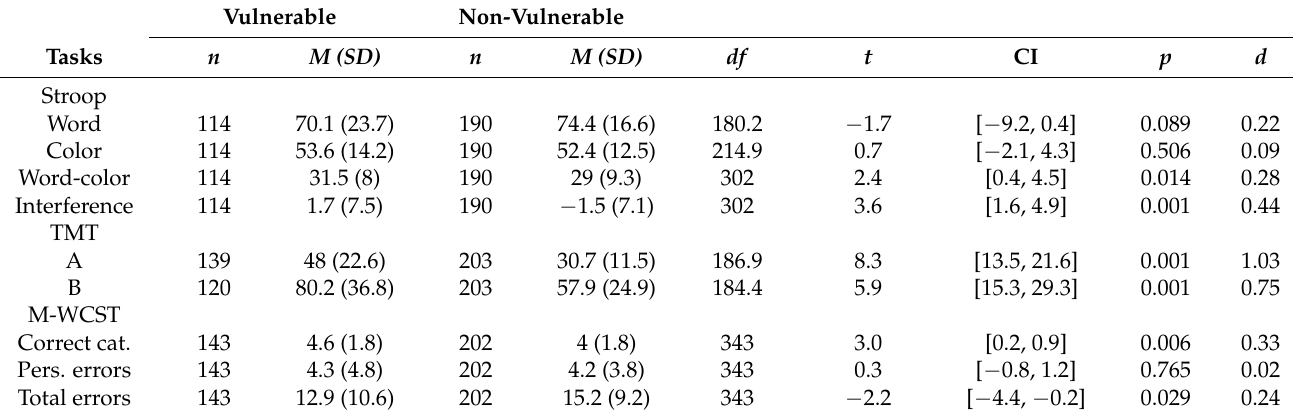
Table 4. Executive functions tests raw scores and independent samples t -test results. Vulnerable